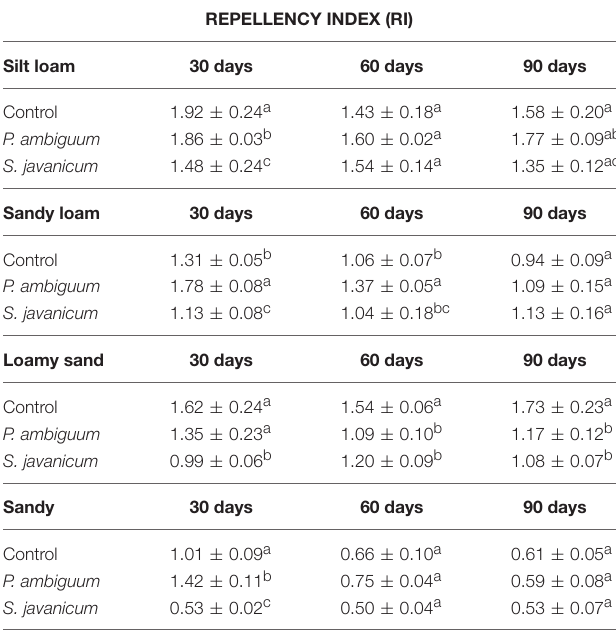
TABLE 4 | Repellency index (RI) in control and inoculated soils after 30, 60, 90 days of